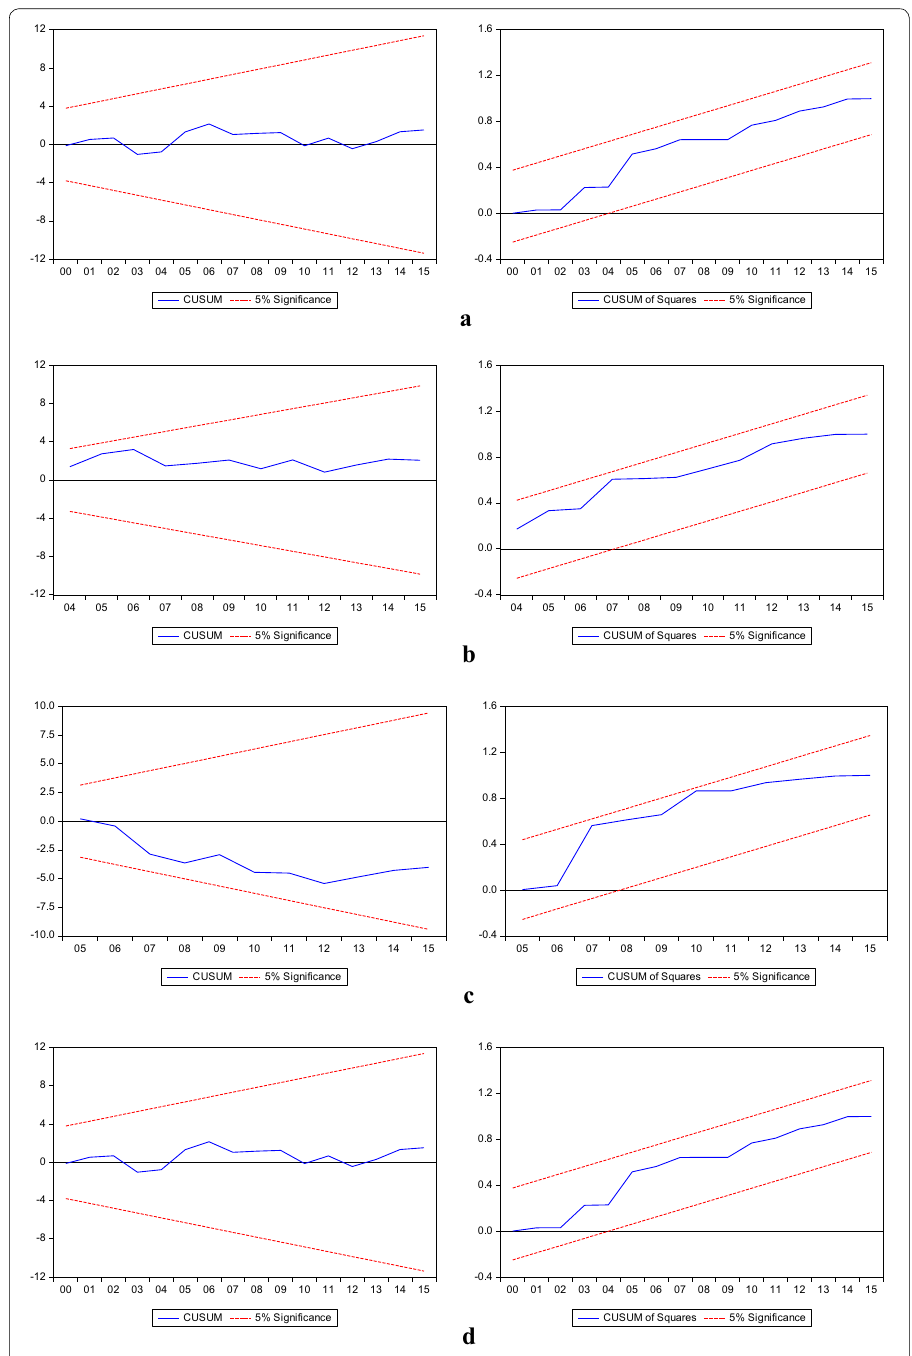
Fig. 2 The plots of the cumulative sum and the cumulative sum of the squares of recursive residuals. a Overall financial development index . b Banking sector development index. c Stock market